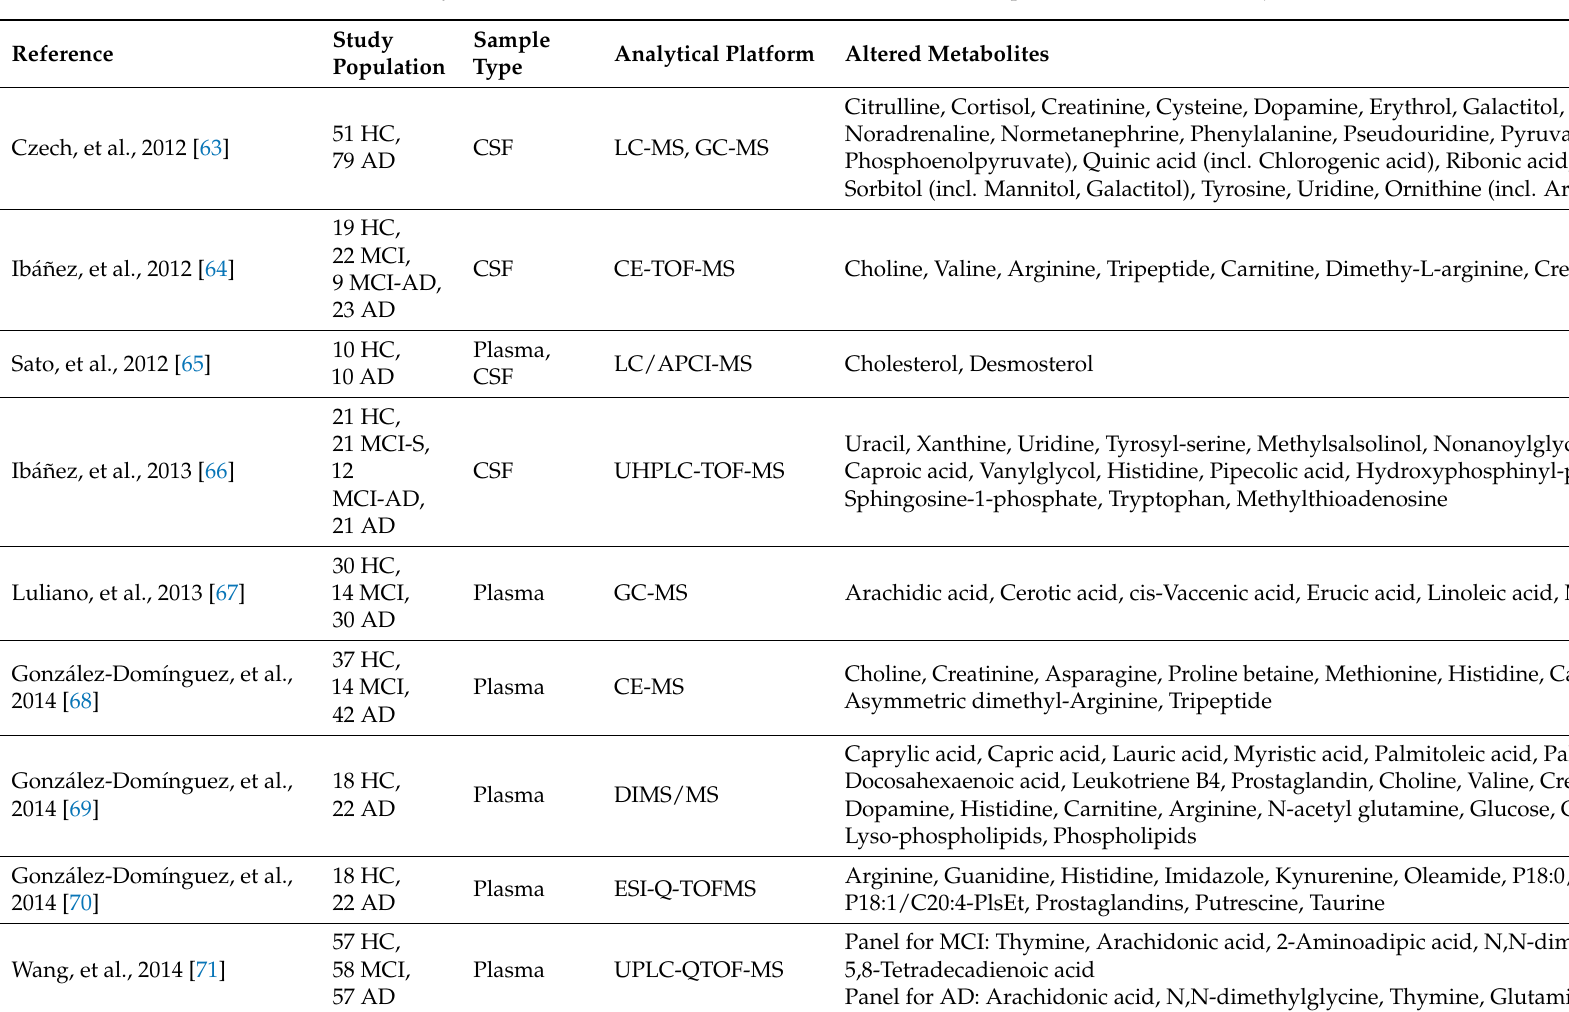
Table 1. Summary of the included articles related to metabolomics studies performed on human